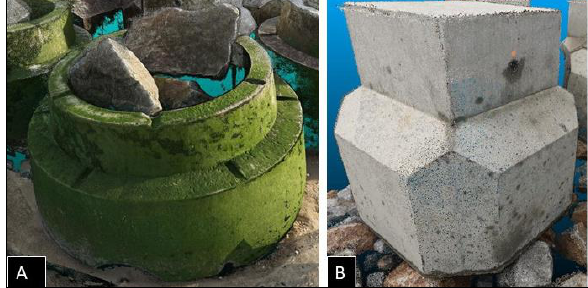
Figure 1 . A: Accroberm TM II (2.24 m diameter); B: ‘double cube’ unit (1.3 m nominal diameter)